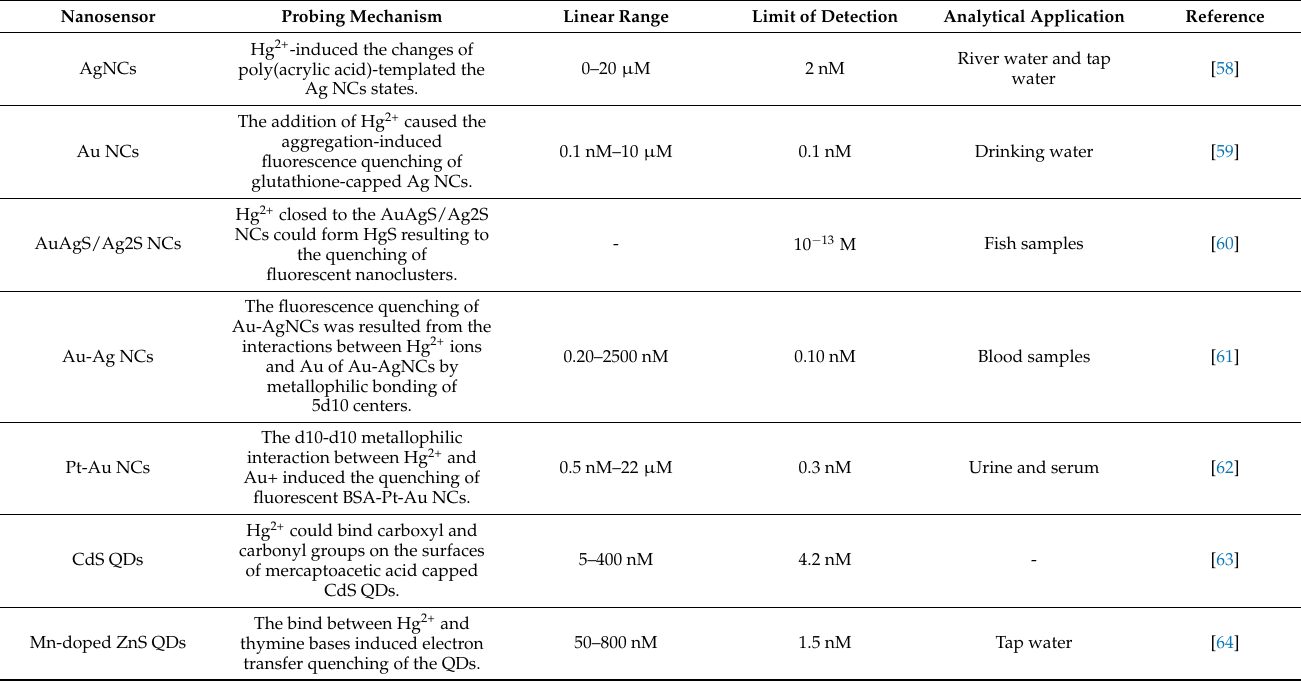
Table 1. Characteristic features of fluorescent nanosensors for Hg(II)